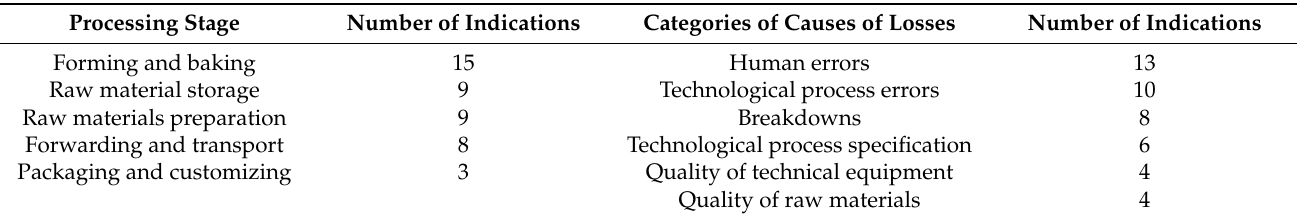
Table 4. Technological operations with the highest risk of food losses in baking and confectionery industry and their causes.